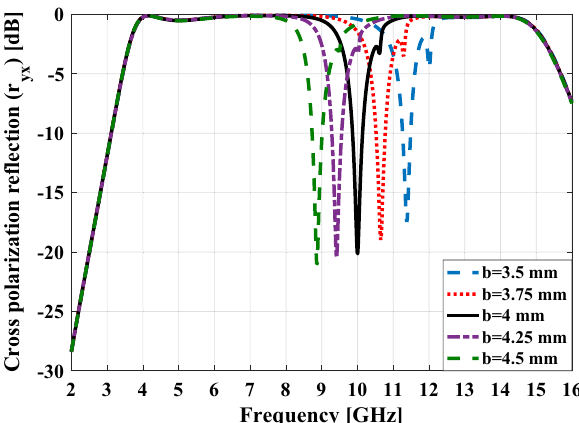
Figure 8. The cross-polarization reflection for proposed unit cell versus frequency in different b